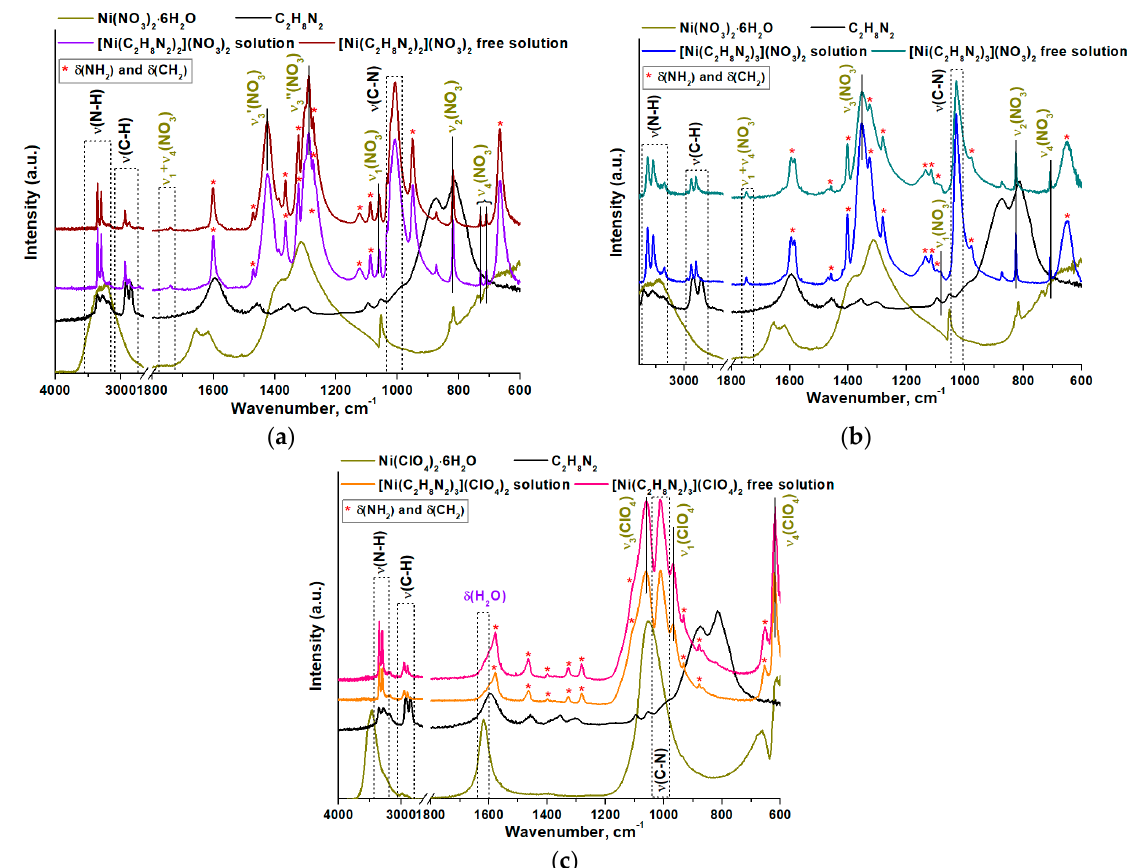
Figure 2. ATR FTIR data for obtained ( a ) [Ni(C 2 H 8 N 2 ) 2 ](NO 3 ) 2 , ( b ) [Ni(C 2 H 8 N 2 ) 3 ](NO 3 ) 2 and ( c ) [Ni(C 2 H 8 N 2 ) 3 ](ClO 4 ) 2 complexes. ( c ) [Ni(C 2 H 8 N 2 ) 3 ](ClO 4 ) 2 complexes.